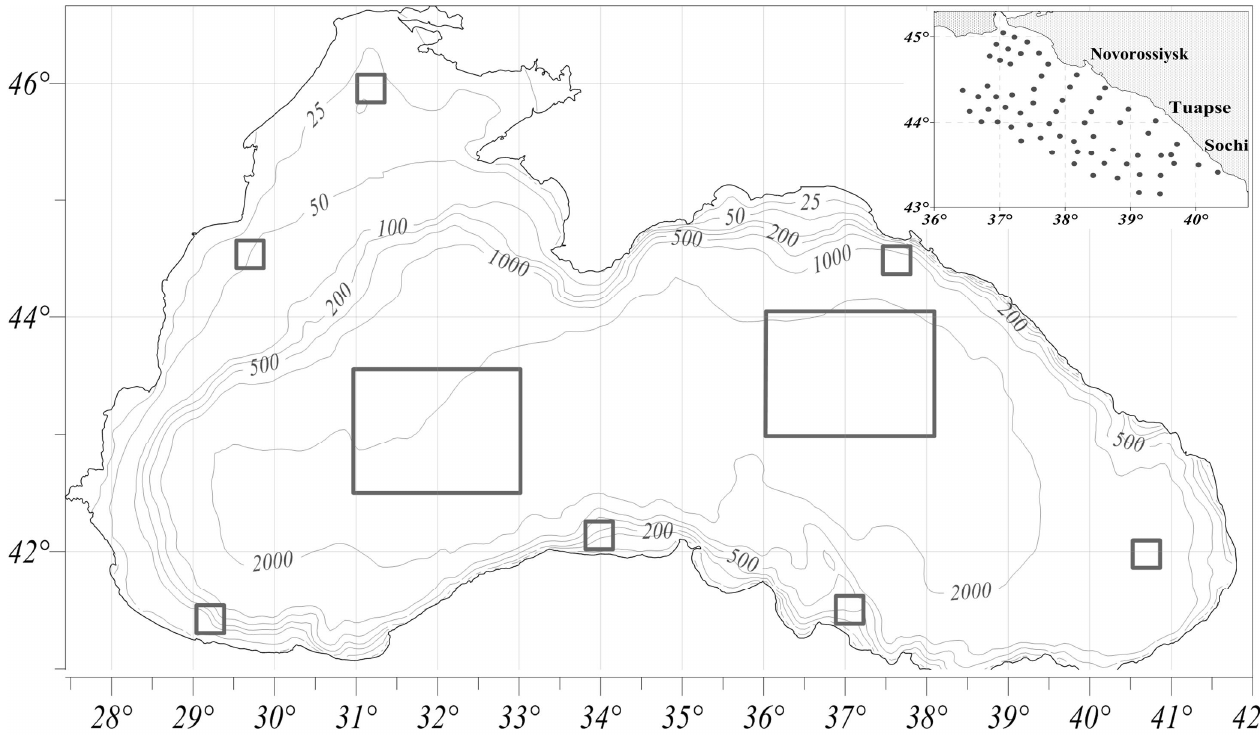
Figure 2. Location of the long-term satellite observations areas and sampling stations of field studies in the Black Sea.